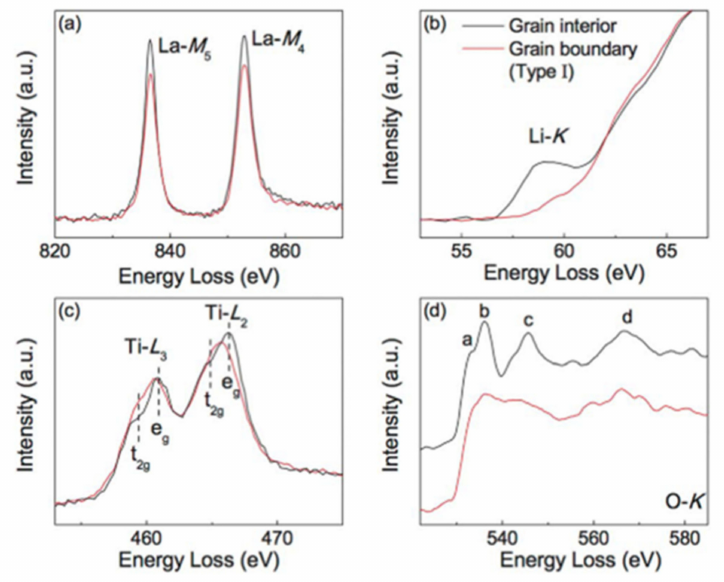
Figure 36. EELS data of ( a ) La-M 4,5 , ( b ) Li-K, ( c ) Ti-L 2,3 , and ( d ) O-K edges for the type I GB and the bulk. The spectra were normalized to the integrated intensity of the Ti-L 2,3 edge [20]. Reproduced from [20] with permission from the Royal Society of Chemistry, Copyright 2014.